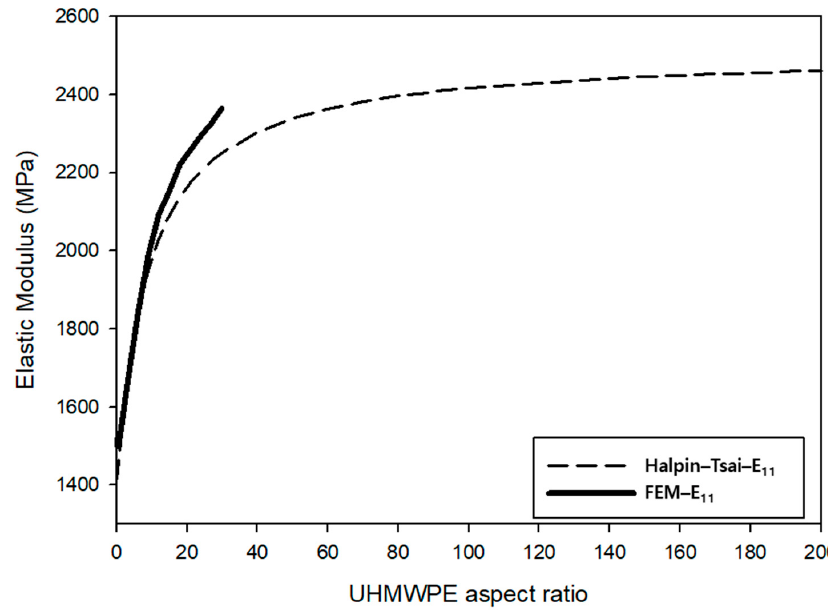
Figure 3. Elastic modulus (E 11 ) according to the UHMWPE aspect ratio.